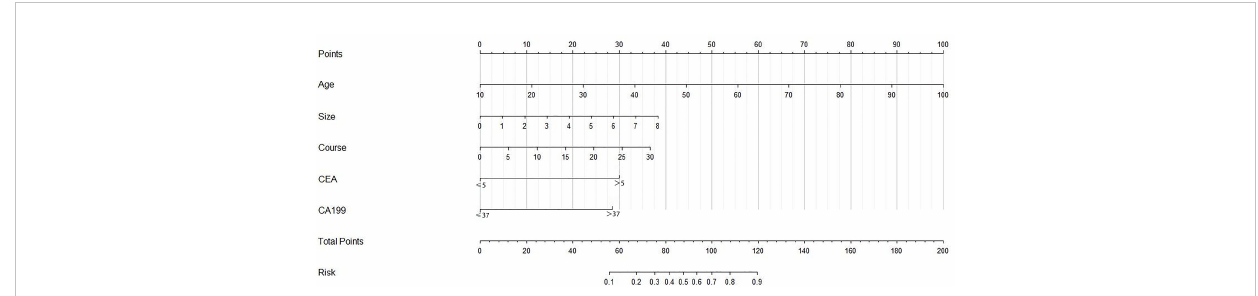
FIGURE 2 The nomogram model for predicting the risk of GBC in patients with gallstones. CEA, carcinoembryonic antigen (ng/ml); CA199, carbohydrate antigen 199 (U/ml); Size, size of gallstones (cm); Course, course of gallstones